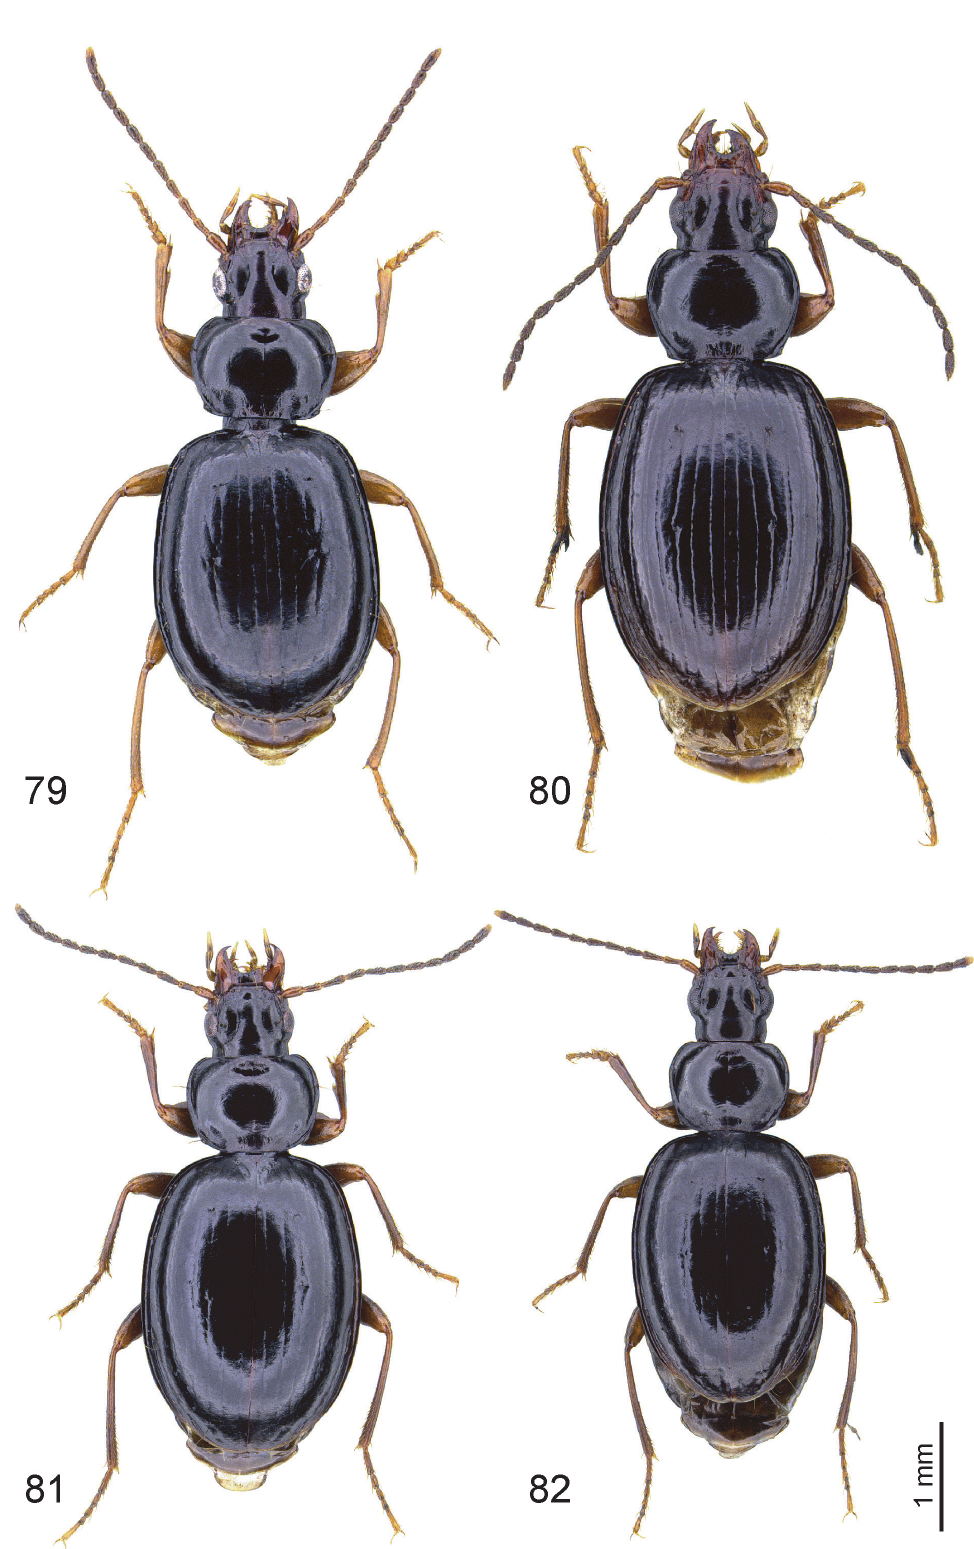
Figs 79–82. Trechus spp., habitus. 79 . T. wiersbowskyi sp. nov., paratype, ♂; 80 . T. grandipennis sp. nov., holotype. 81 . T. sanettii sp. nov., paratype, ♂. 82 . T. abalkhasimi sp. nov., paratype,